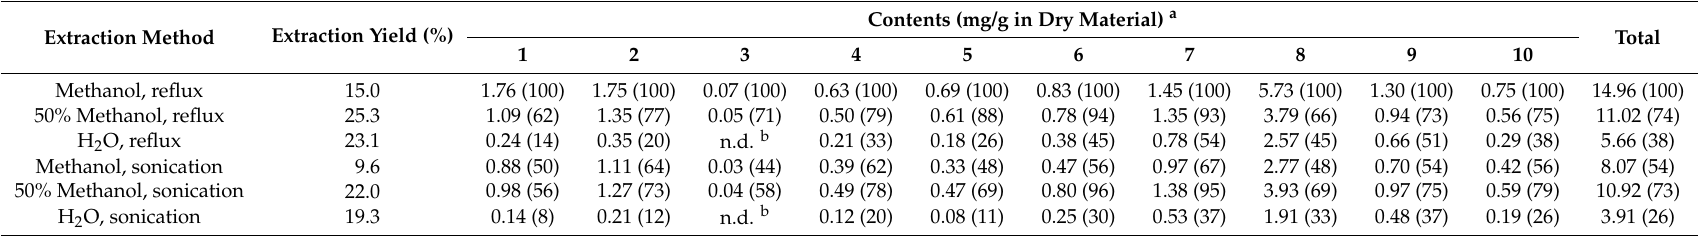
Table 2. Extraction efficiently of alkaloids ( 1 – 10 ) from lotus flower.